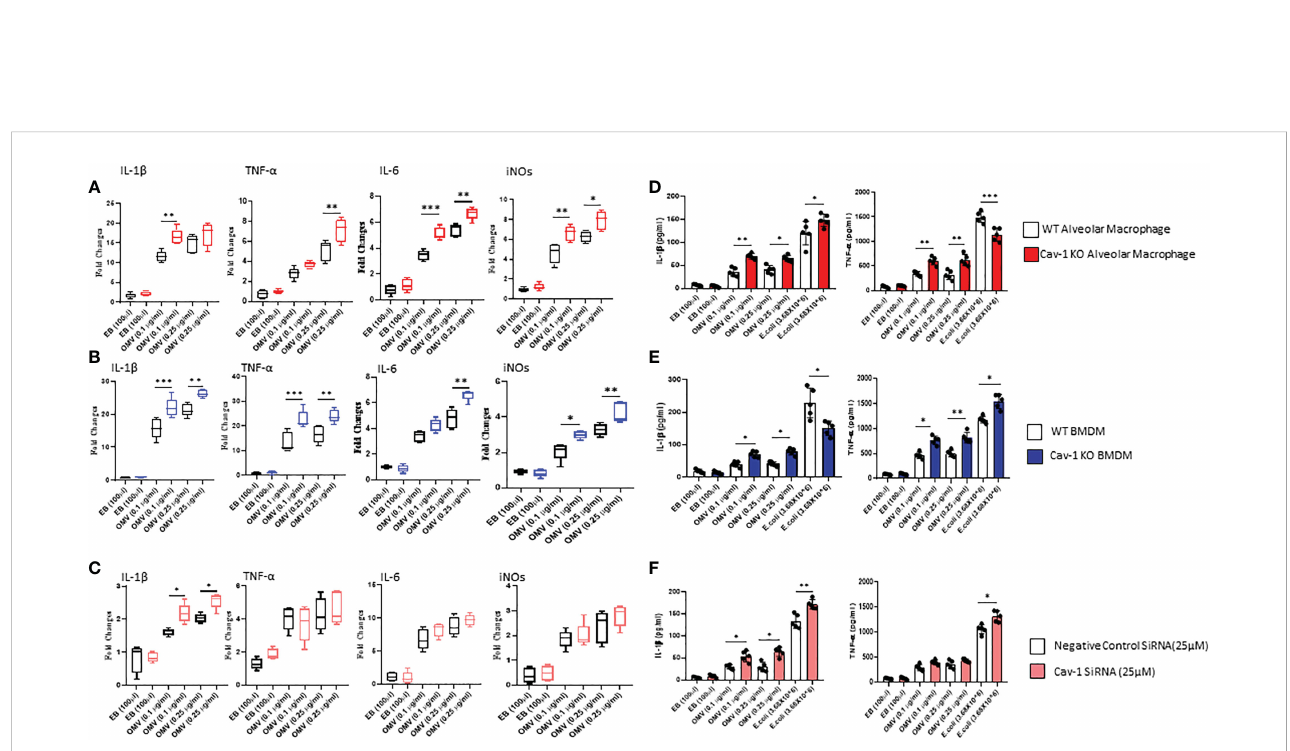
FIGURE 2 Effect of OMVs on proin fl ammatory mediator secretion. WT and Cav-1 KO AM Ф , BMDM, and human THP-1 cells were treated with different concentrations (0.1 and 0.25 m g/ml) of OMVs or E. Coli (3.68X10 6 ); after 24h, gene expression of proin fl ammatory mediators such as IL1 b , TNF- a , IL-6, and iNOs (A – C) using qRT PCR method. Secretory levels of IL1 b and TNF a (D – F) were quanti fi ed in the culture supernatant using the ELISA technique. Results were expressed as mean ± SD. Statistical Analysis was performed non-parametrically using the One-way Analysis of variance (ANOVA) with Tukey ’ s multiple comparison tests to determine signi fi cant differences between the experimental groups. *p < 0.05, **p<0.01 and ***p<0.005 set as Statistical signi fi